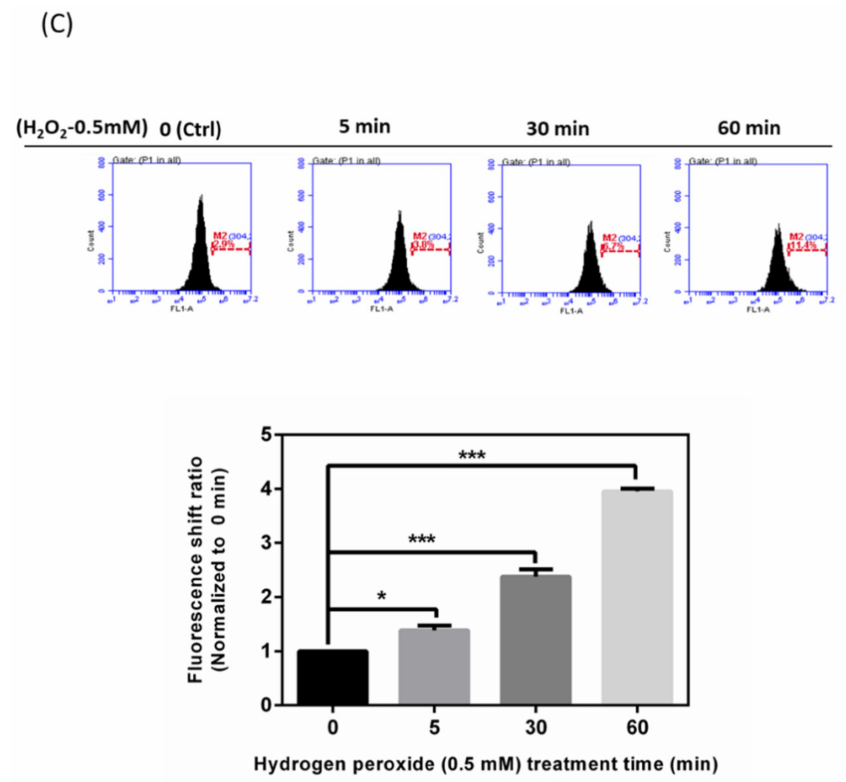
Figure 1. Impairments by H 2 O 2 of human trabecular meshwork cells (HTMCs). H 2 O 2 treatment de- creased cell viability and increased reactive oxygen species (ROS) along with Ca 2+ levels in dose- and time-dependent manners. ( A ) MTT (3-(4,5-dimethylthiazol-2-yl)-2,5-diphenyltetrazoliumbromide) cell viability of different concentrations of H 2 O 2 for 1 (upper panel) and 24 h (lower panel) of treat- ment was evaluated. The various concentrations were normalized to 0 µ M. Histogram values reflect the mean ± standard error of the mean (SEM). Values in the plots are normalized against the control group (0 mM) ( n = 4, independent experiments). ( B ) The increase in ROS with H 2 O 2 (0.5 mM)-treated HTMC over 5, 30, and 60 min. Histogram values reflect the mean ± SEM. Values in the plots are normalized against the control group (0 min); * p < 0.05, ** p < 0.01, and ns, non-significant when compared to the control group ( n = 3, independent experiments). ( C ) Histograms showing decreased levels of Ca 2+ content during H 2 O 2 (0.5 mM) treatment. Values reflect the mean ± SEM and are normalized against the control group (0 min); * p < 0.05 and *** p < 0.001 when compared to the control group ( n = 3, independent